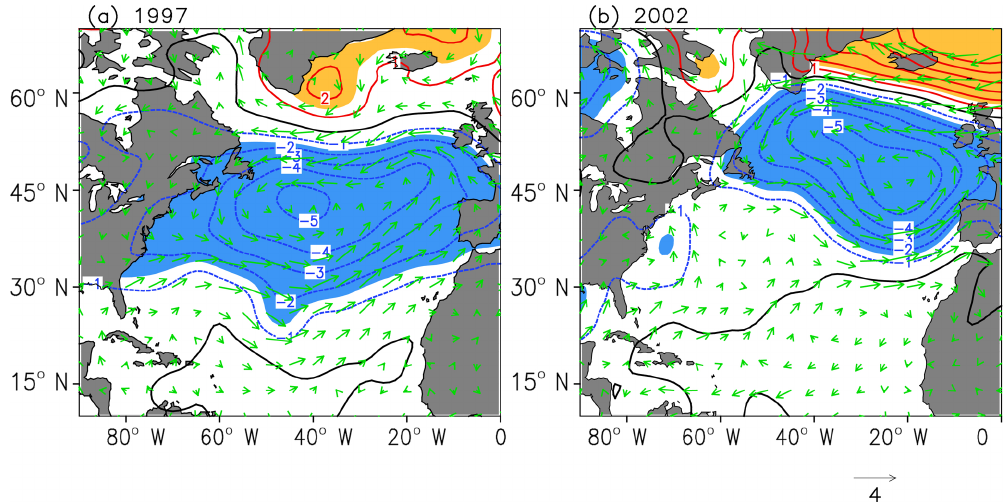
Figure 7. The horizontal distribution of surface wind (ms − 1 ) and surface-level pressure (hPa) based on assimilated meteorological data during the autumns of (a) 1997 and (b) 2002.